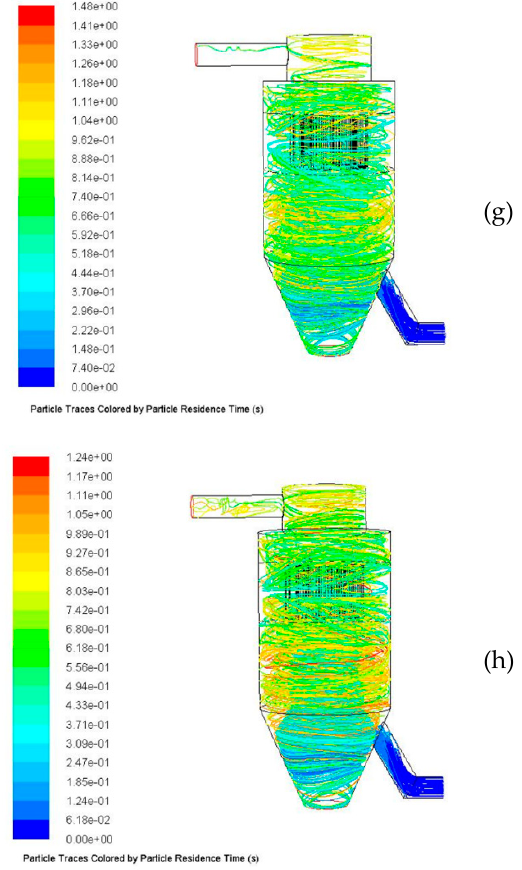
Figure 5. Particle tracks for 8 groups of different rotor speeds and air inlet velocity. ( a ) Rotor speed 1600 rpm, air inlet velocity 6 m / s. ( b ) Rotor speed 2200 rpm, air inlet velocity 6 m / s. ( c ) Rotor speed 1800 rpm, air inlet velocity 8 m / s. ( d )Rotor speed 2200 rpm, air inlet velocity 8 m / s. ( e ) Rotor speed 1800 rpm, air inlet velocity 10 m / s. ( f ) Rotor speed 2000 rpm, air inlet velocity 10 m / s. ( g ) Rotor speed 2000 rpm, air inlet velocity 12 m / s. ( h ) Rotor speed 2200 rpm, air inlet velocity 12 m / s.